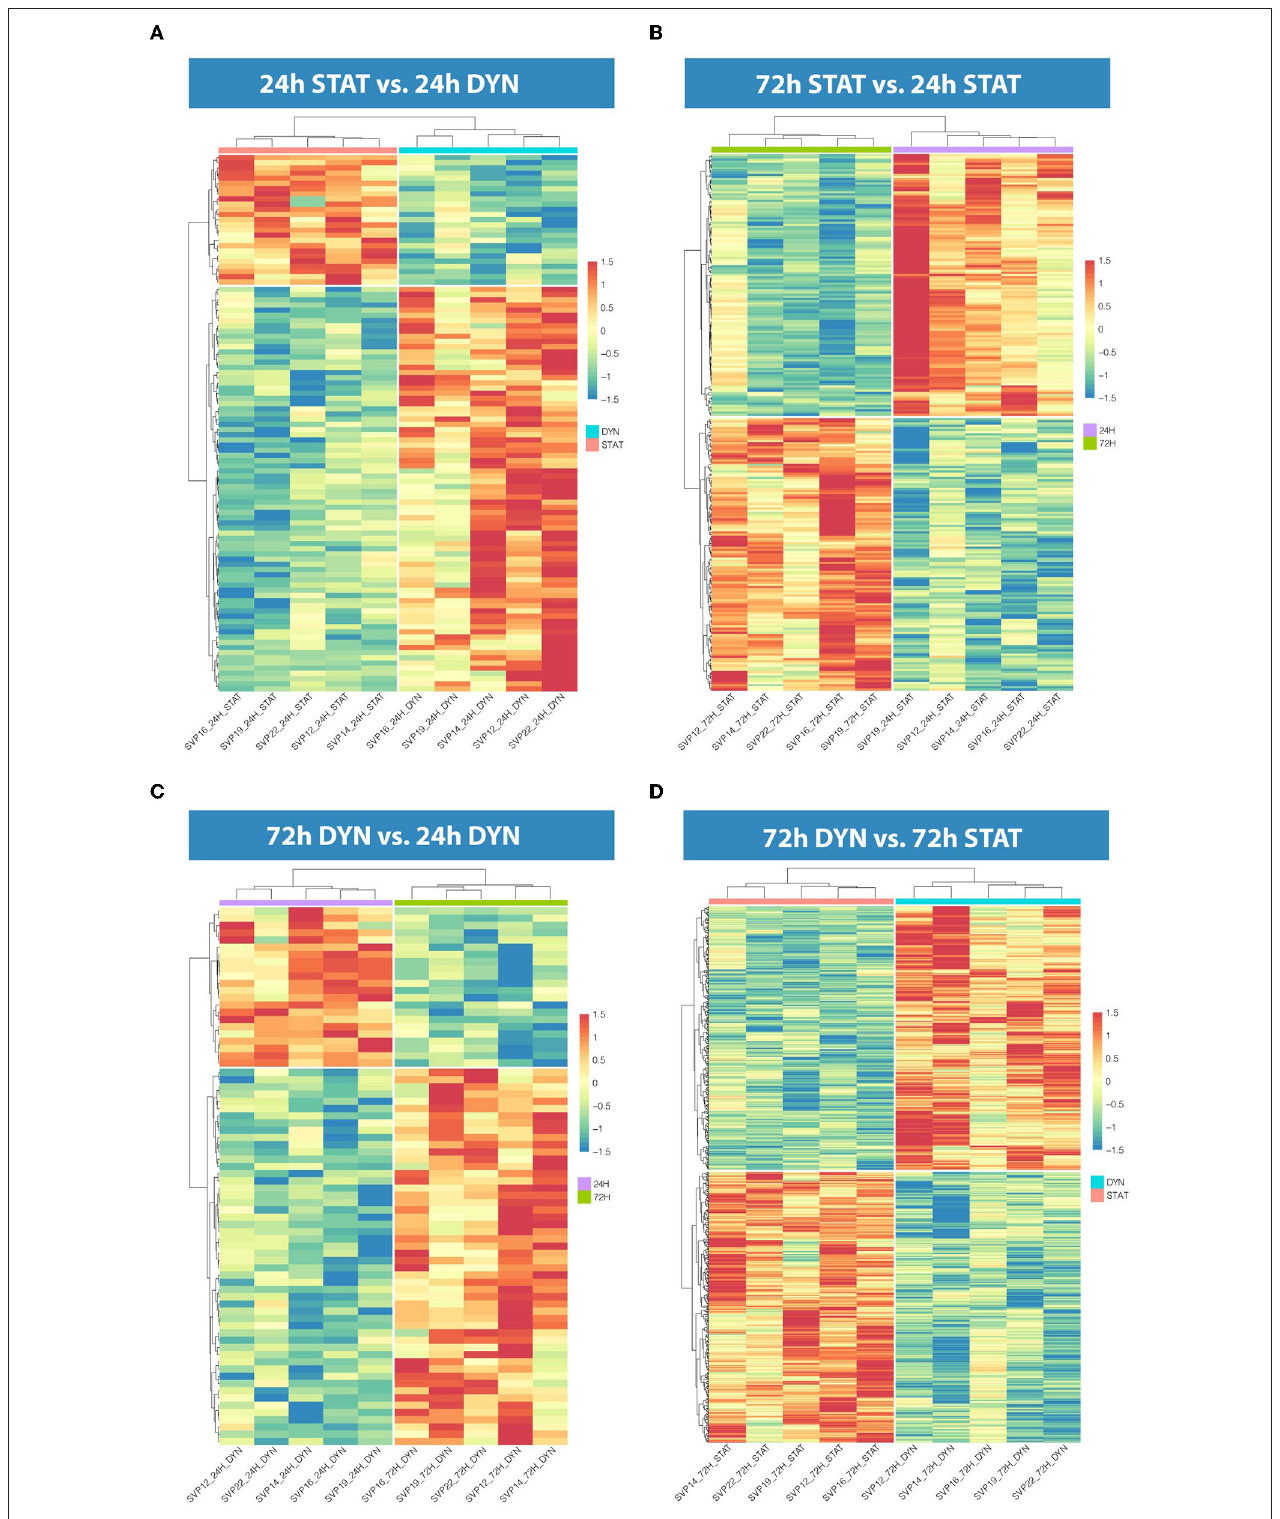
FIGURE 1 | Hierarchical clustering in the four comparisons. (A) Heatmap representation showing 103 DEGs in 24h dyn vs. 24h stat. (B) Heatmap representation showing 245 DEGs in 72h stat vs. 24h stat. (C) Heatmap representation showing 72 DEGs in 72 h dyn vs. 24 h dyn. (D) Heatmap representation showing 819 DEGs in 72 h dyn vs. 72h stat. For all heatmaps BH-adjusted p -value ≤ 0.05.